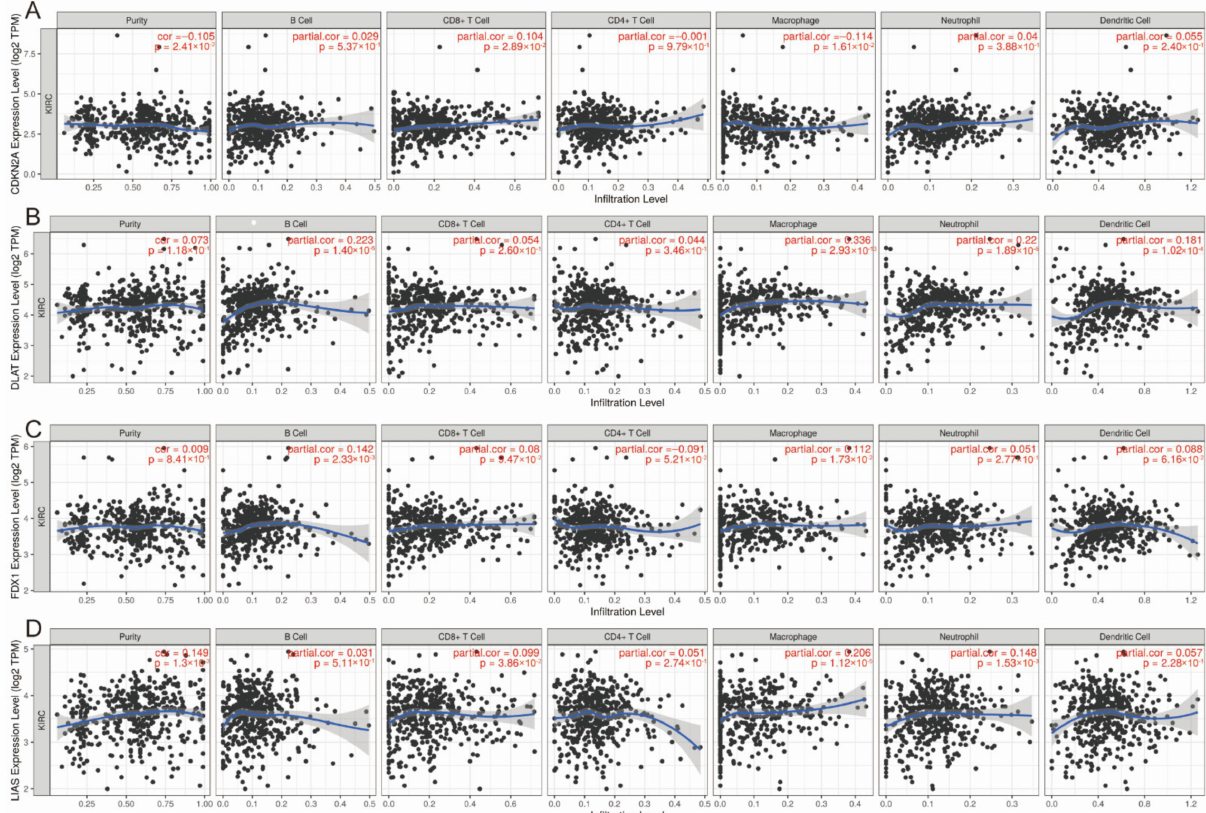
Figure 6. Correlation between ( A ) CDKN2A , ( B ) DLAT , ( C ) FDX1 and ( D ) LIAS expression and immune infiltration in ccRCC in the TIMER database. ccRCC: clear cell renal cell carcinoma.